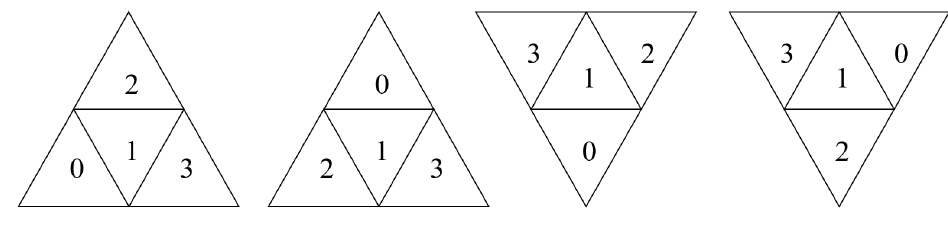
Figure 5. Quaternary encoding method.